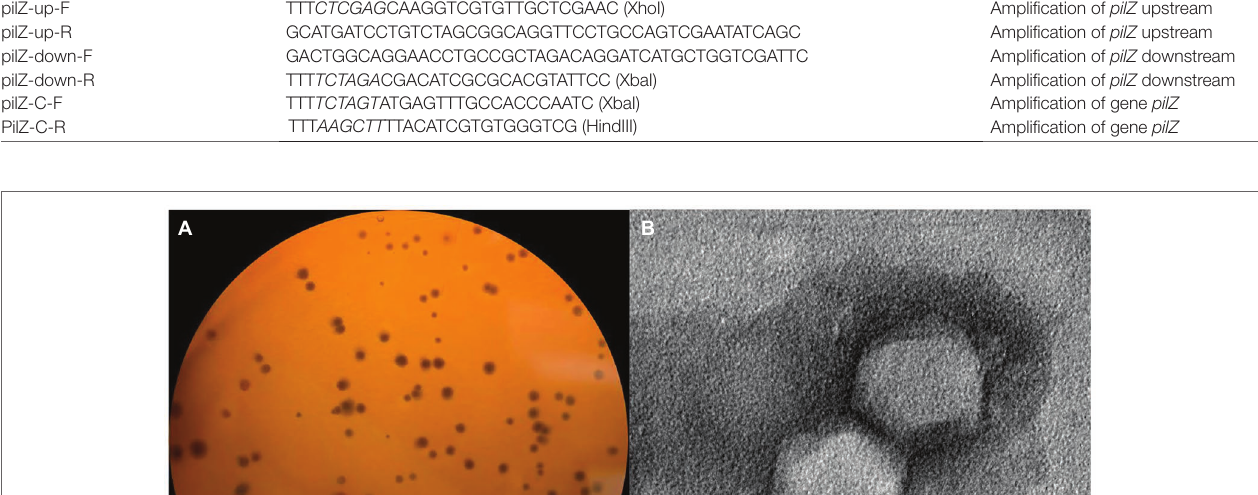
TABLE 2 | Primers used in this study. Primer Sequence (5 ′ -3 ′